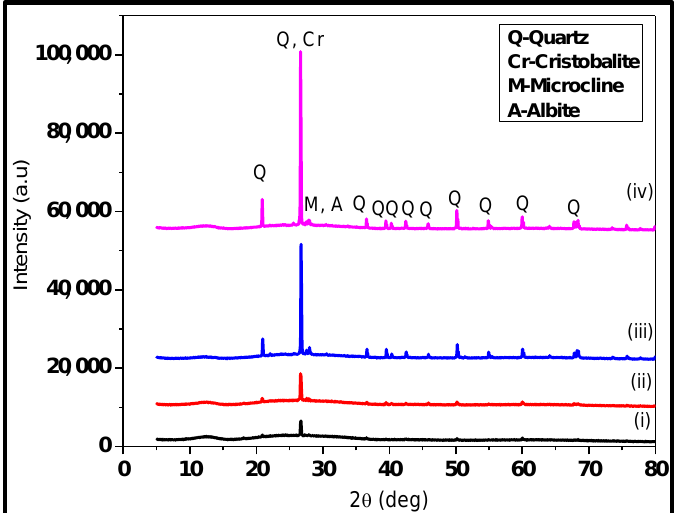
Figure 1. The XRD patterns for bagasse (i) SCBA CA leached (ii) CA-TPAH silica calcined bagasse (iii) SCBA L-Cys leached and (iv) L-cys-TPAH silica.